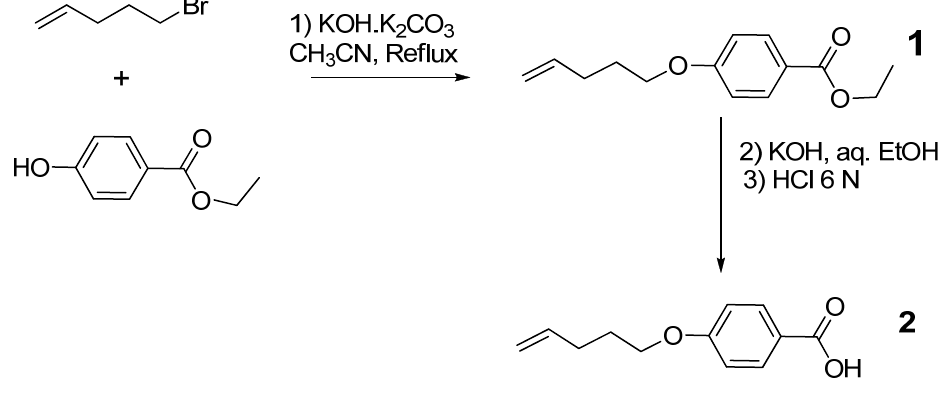
Figure 1. Thermogravemetric analysis of monomer 2